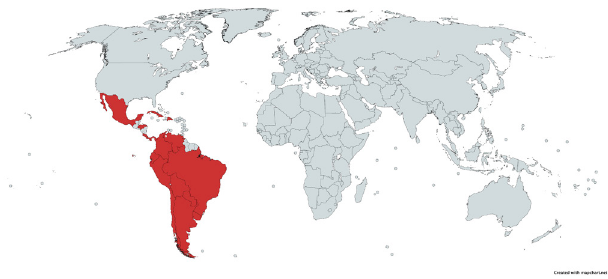
Fig. 1 - Countries of origin of eligible survey